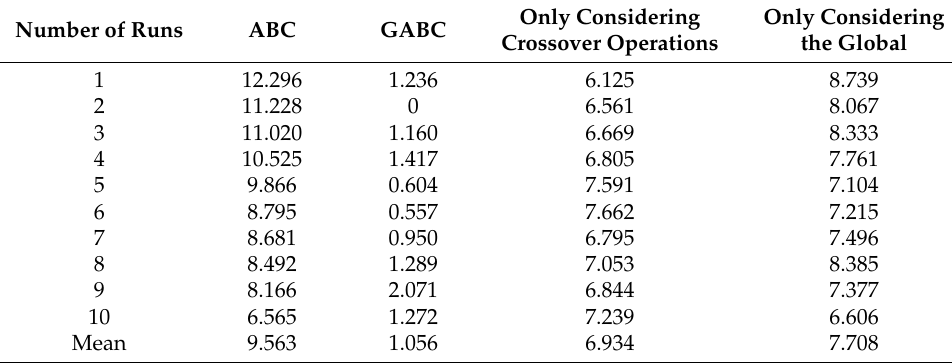
Table 12. RPI values obtained by different